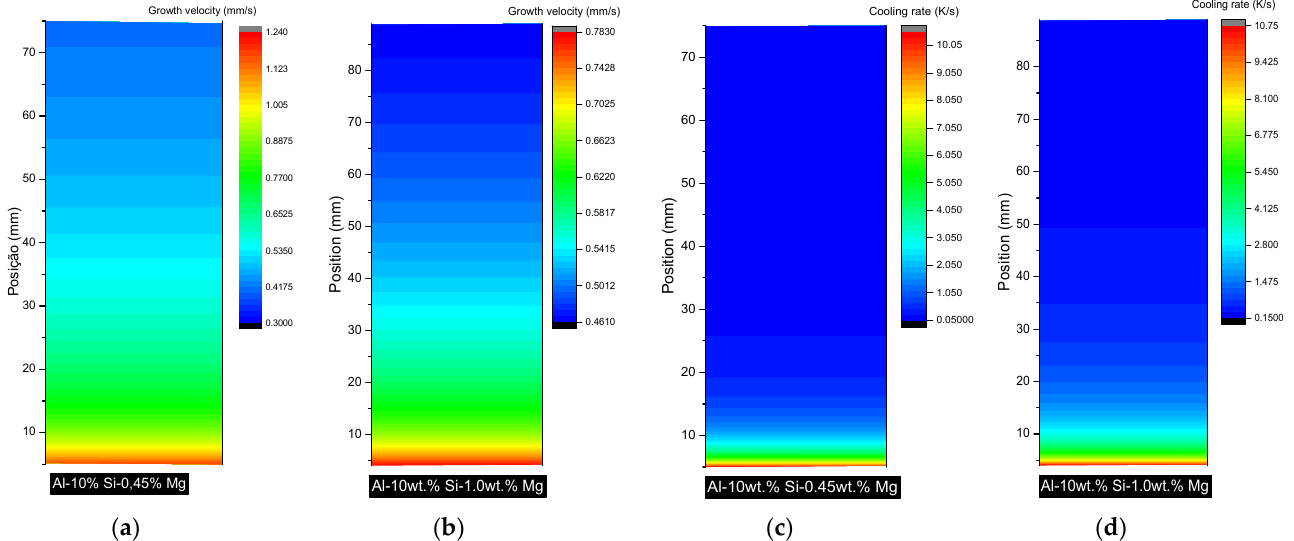
Figure 3. Representations in color maps of the evolution of growth velocities and cooling rates from top to bottom along the length of the solidified Al-Si-Mg bodies: ( a , b ) V L and ( c , d ) Ṫ for both examined alloys.